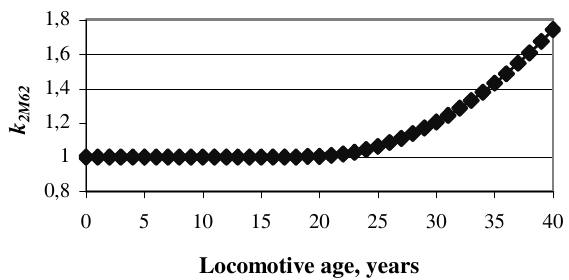
Fig 2. The relationship between the dimensionless indicator and the locomotive